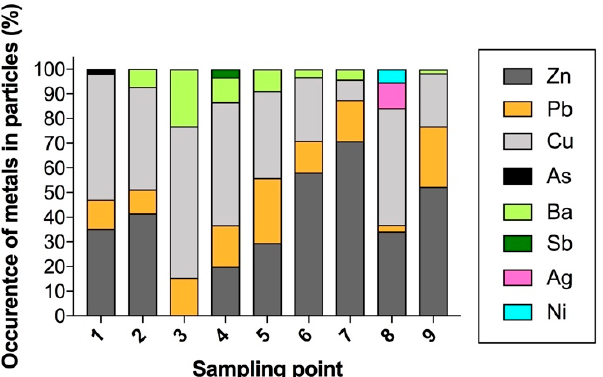
Figure 9. Frequency of occurrence of individual metals in studied inorganic atmospheric particles.